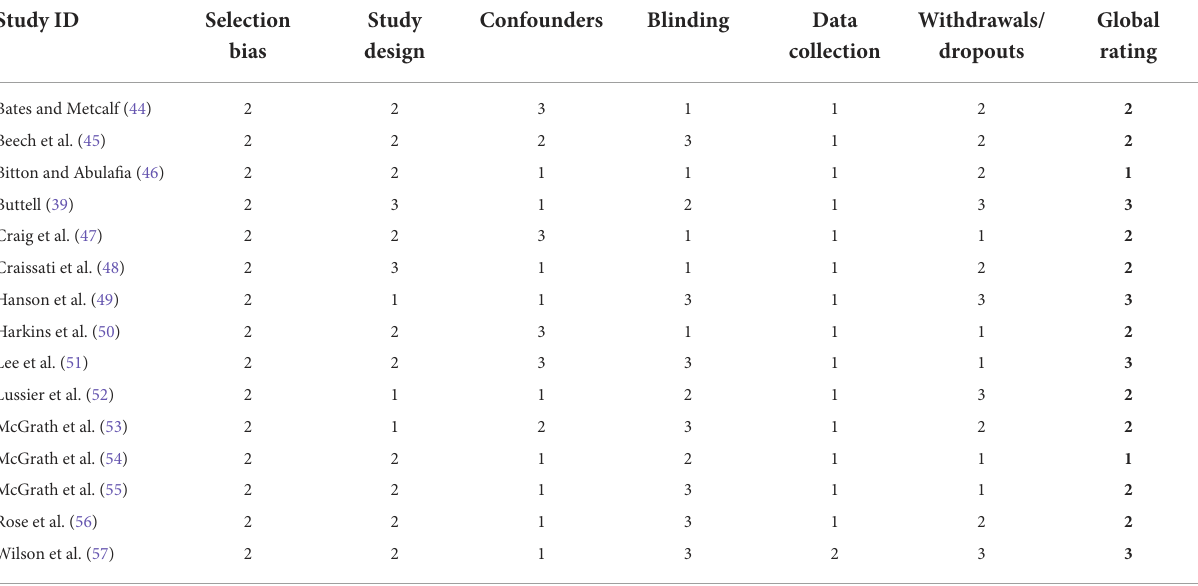
TABLE 1 Quality assessment ratings of included studies using the EPHPP quality assessment tool for quantitative studies. Study ID Selection